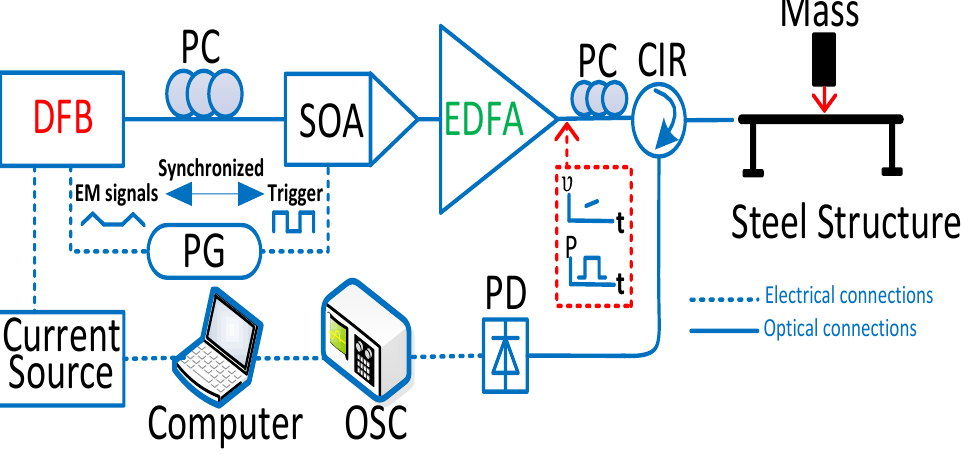
Figure 2. Schematic of the chirped pulse ϕ -OTDR sensing system. DFB, distributed feedback laser; SOA, semiconductor optical amplifier; EDFA, Erbium-doped fiber amplifier; PC, polarization controller; PG, pulse generator; PD photo-detector; OSC, oscilloscope; EM, electrical modulation; CIR,